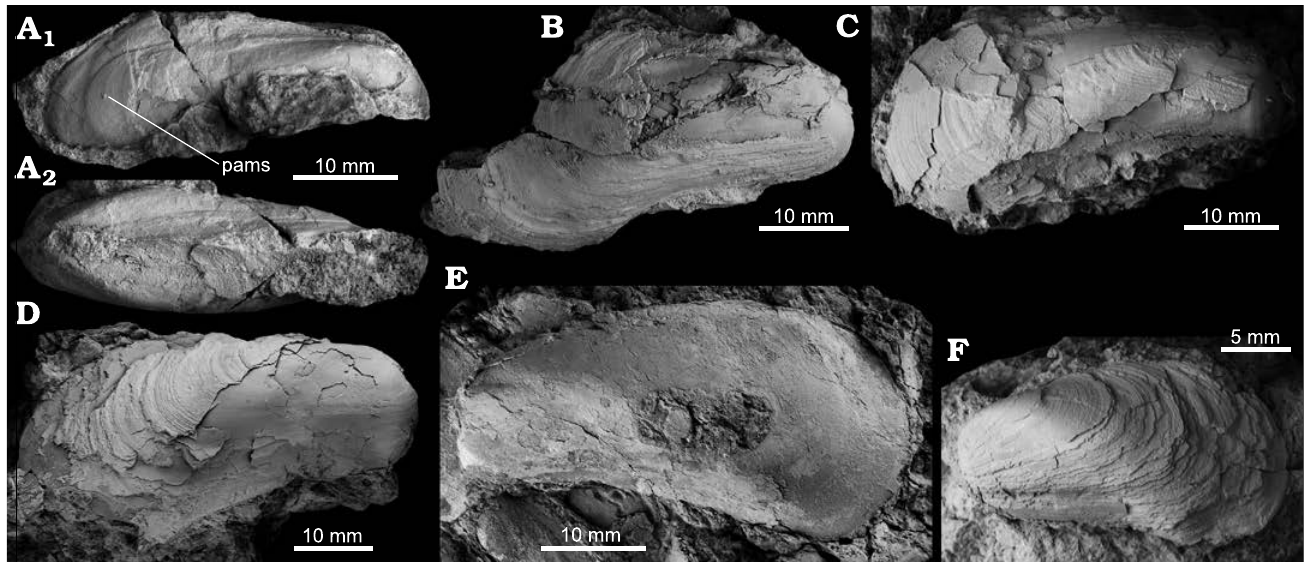
Fig. 5. The bathymodiolin bivalve Bathymodiolus labayugensis sp. nov. from Upper Miocene seep deposits of the Amlang Formation in Pangasinan province, Luzon, Philippines. A . NRM Mo 192681, internal mold showing posterior adductor muscle scar (A 1 , pams) and dorsal view showing inflation (A 2 ). B . NRM Mo 192684, external view of RV. C . NRM Mo 192682, external view of RV. D . NRM Mo 192683, external view of RV. E . NIGSPAL-005, holotype, external view of RV. F . NRM Mo 192532, paratype, external view of